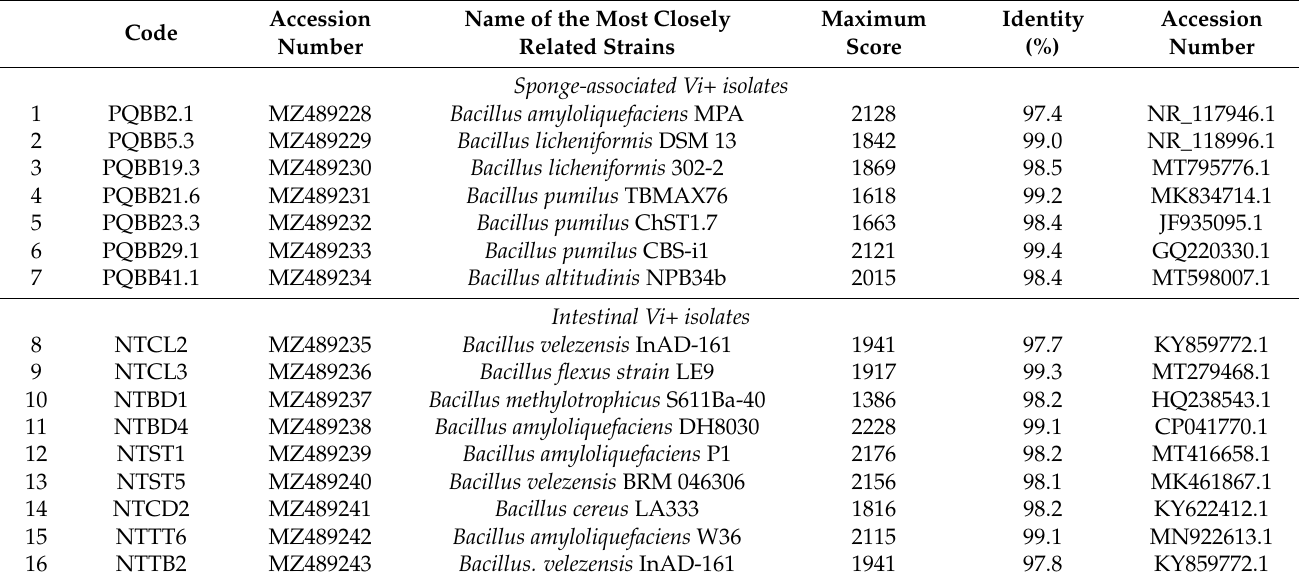
Table 2. Sequence analysis of 16S rRNA genes of the Vi+ using BLAST n.